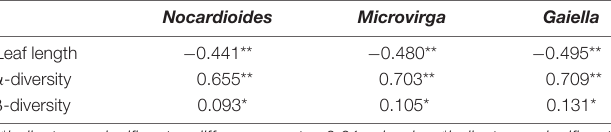
TABLE 3 | Identified keystone bacterial genera that affect the endophytic bacterial community across different rice